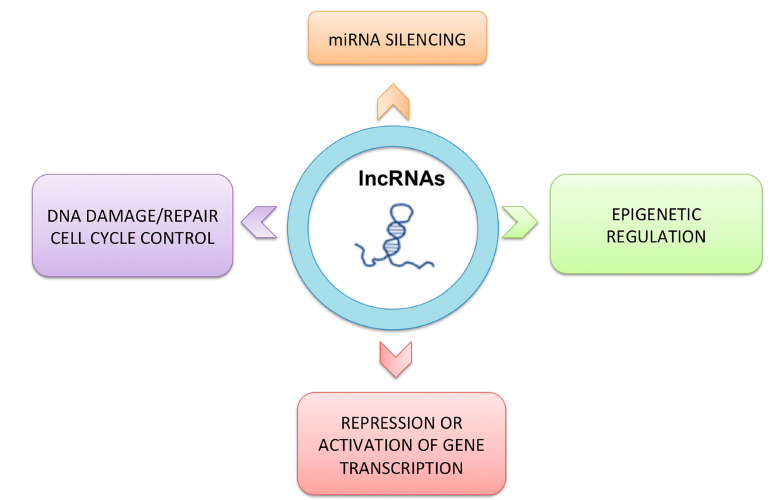
Figure 2. Functionoflongnon-codingRNAs.